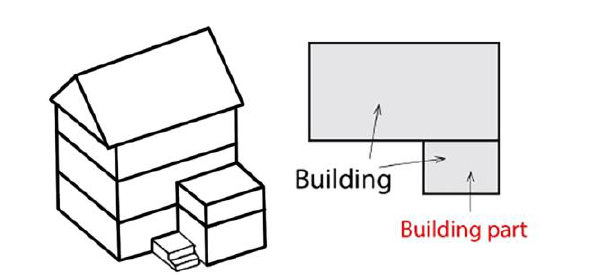
Fig. 2. Example of “building parts” in the ALKIS. Adapted from the official documentation of the ALKIS [17]. Building parts have a separate number of storeys. We use this to either increase (higher building Gebaeudeteil (nicht Hochhaus) ” or decrease (lower building part “